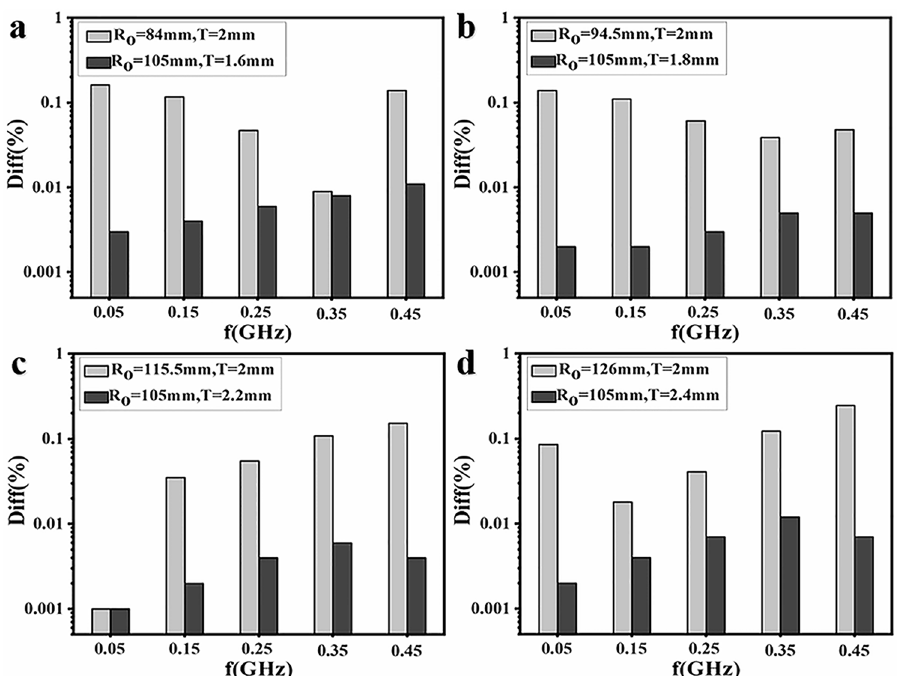
Figure 4. The absolute relative difference between the electric fields in the brain along the Z direction at different frequencies with different adjustment amount of each structural parameter. (a) Decreased by 20%, (b) decreased by 10%, (c) increased by 10%, (d) increased by